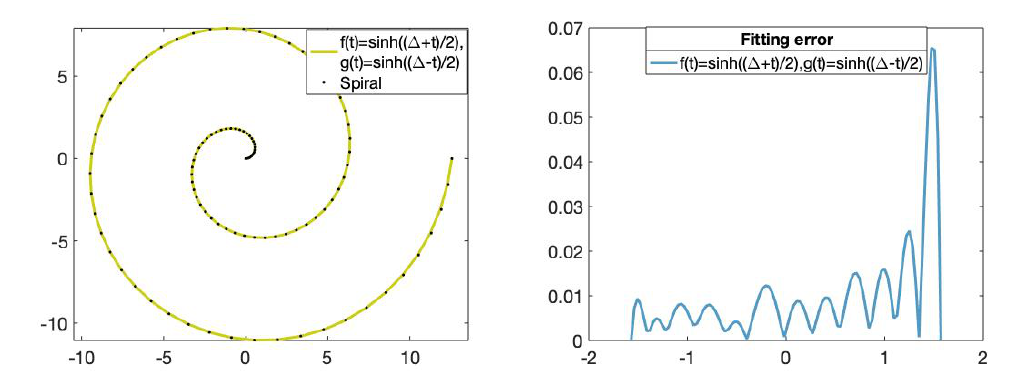
Figure 13. ( Left ): Set of data points on the Archimedean spiral (dotted) and the fitting curve of degree 11 with the functions f ( t ) = sinh (( ∆ + t ) /2 ) and g ( t ) = sinh (( ∆ − t ) /2 ) . ( Right ): The x -axis represents the parameters t in [ − ∆ , ∆ ] and the y -axis represents the fitting error value of the fitting curve obtained using the hyperbolic basis.